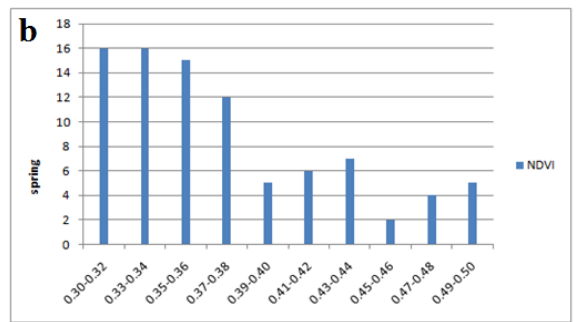
Fig 9. The plot of NDVI pixels vs. the number of springs detected.